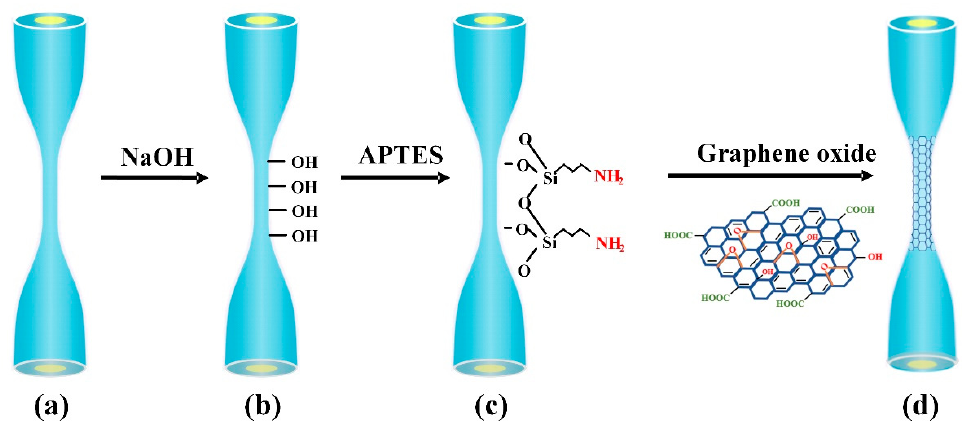
Figure 4. Schematic illustration of functionalization process: ( a ) HNO 3 -cleaned, ( b ) Hydroxyl-groups activated, ( c ) APTES-modified, and ( d ) GO-deposited microfiber.